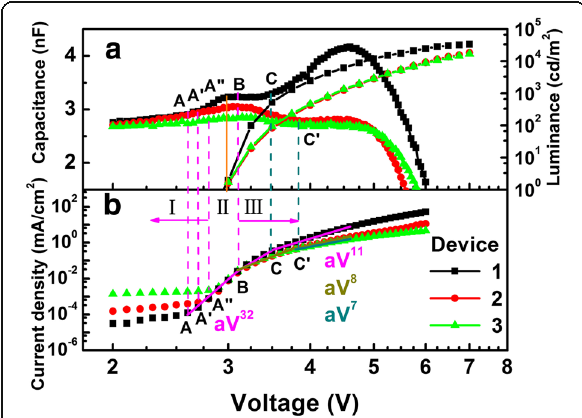
Fig. 1 a Capacitance – voltage – luminance (C-V-L) characteristics of D 1 , D 2 , and D 3 . Orange solid line shows the turn-on voltage corresponding to the maximum of the first peak in their C-V characteristics. b Current density – voltage curves of the three devices in log – log scale, additionally divided into three regions marked by purple dashed lines marked I, II, and III. The current density (J) and voltage (V) conform to the relationship of J ∝ aV